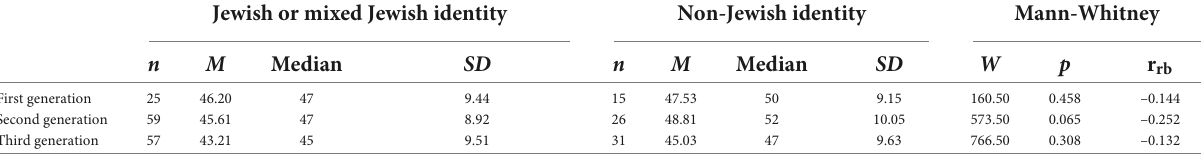
TABLE 5 SOS-10 Differentiation between participants with Jewish identity and Non-Jewish identity in the focal group. Jewish or mixed Jewish identity Non-Jewish identity